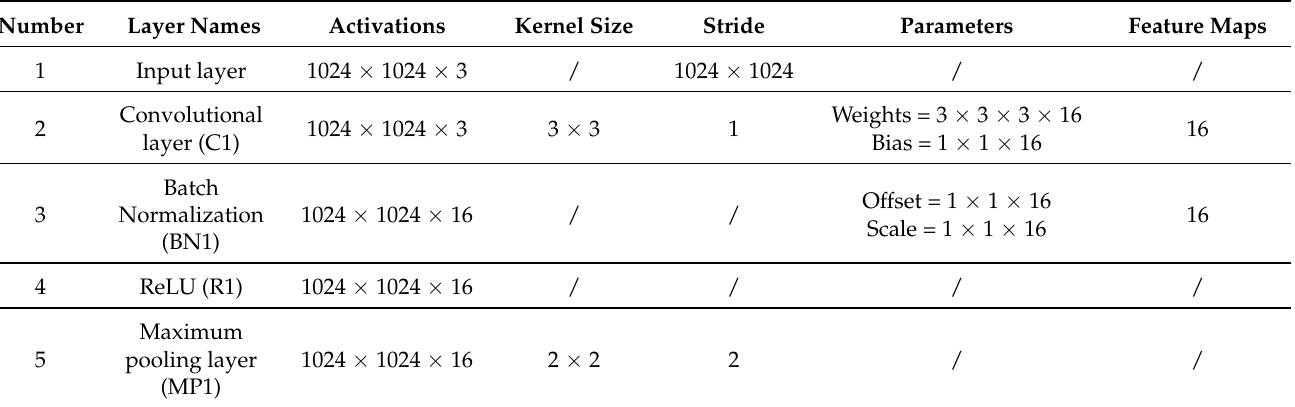
Table 3. Details about the proposed CNN